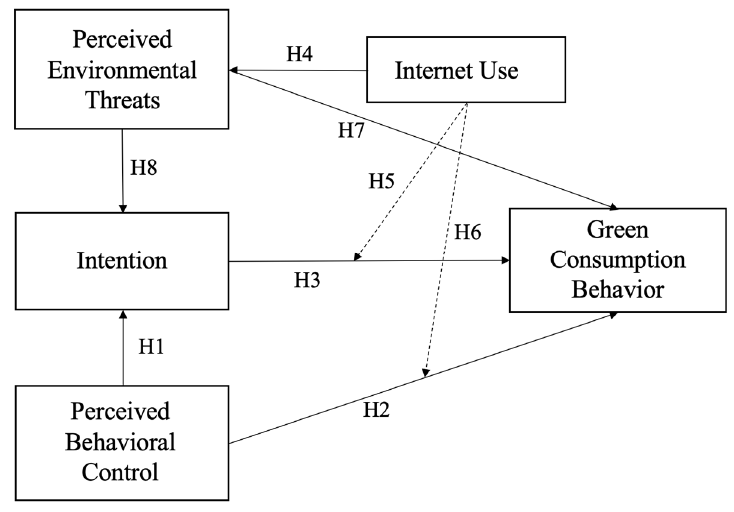
Figure 1. Proposed Framework (Note: Solid lines refer to casual relations, dotted lines refer to moderation effects).